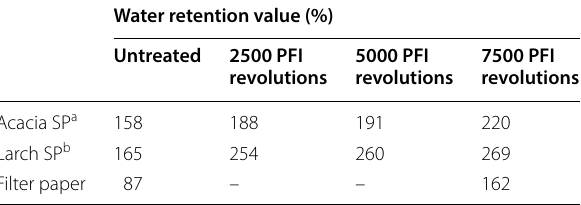
Table 3 The water retention value of pulp